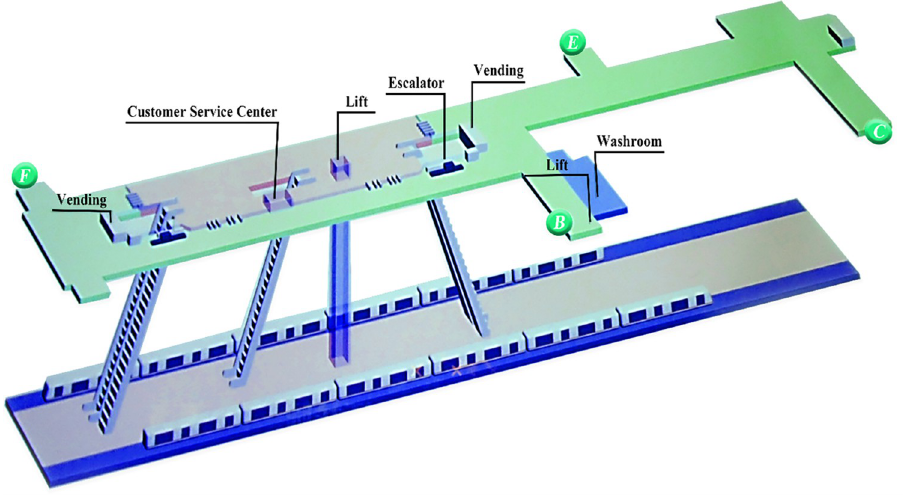
Fig 1. Partial 3D view of ‘GG’